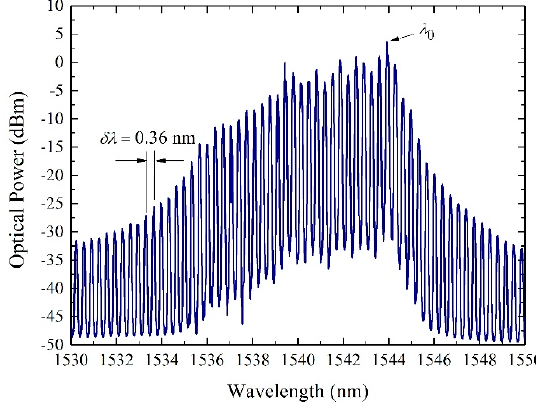
Figure 4. Optical spectrum of the MLD at an injection current of 180 mA.